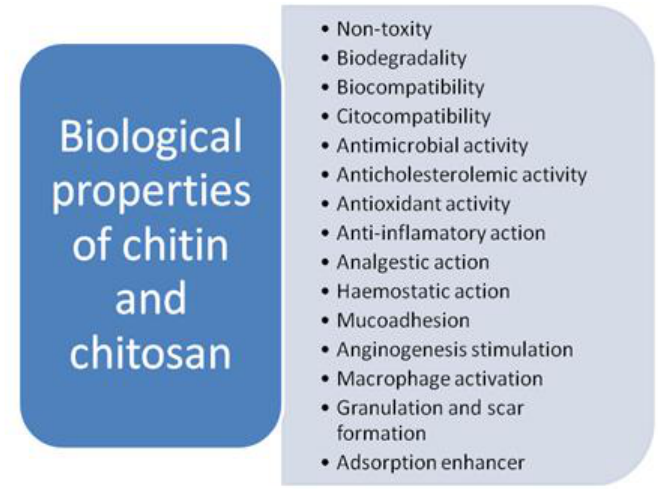
Figure 2. Biological properties of chitin and